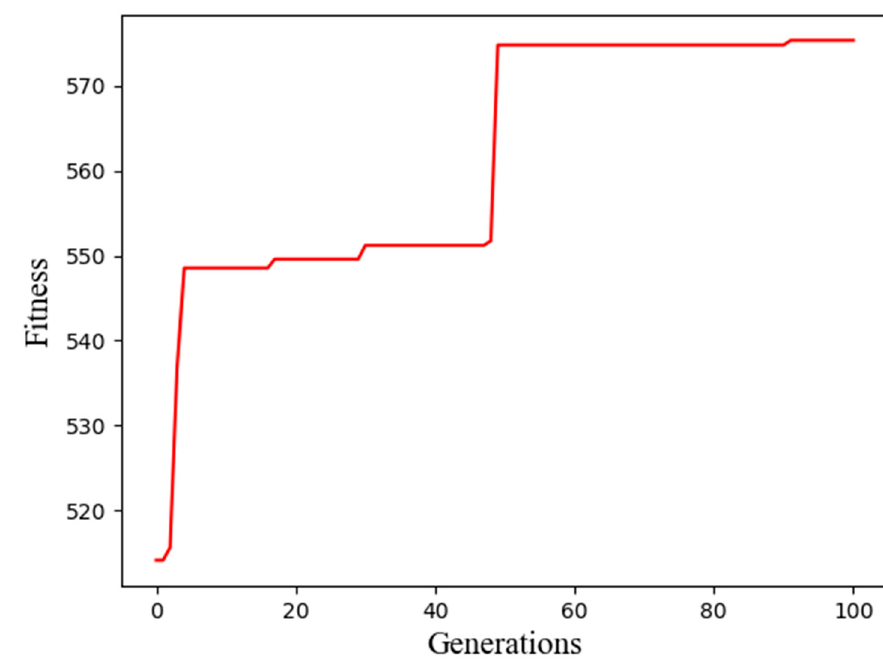
Figure 4. The generations and corresponding best fitness in Dataset 1.